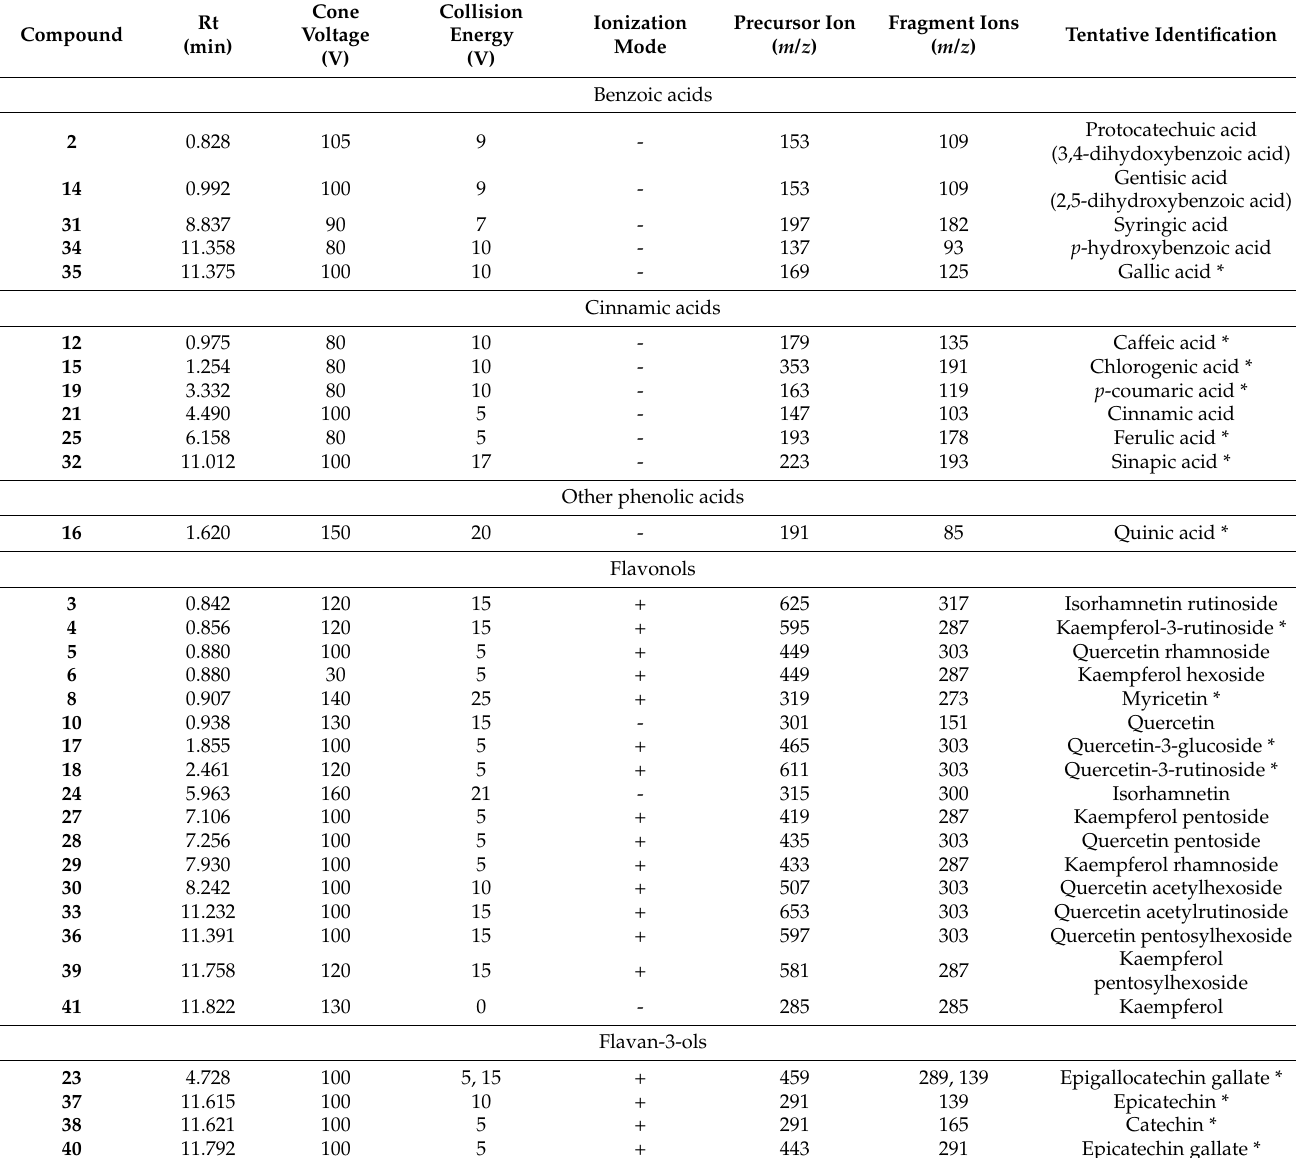
Table 2. Mass spectrometric data and identification of